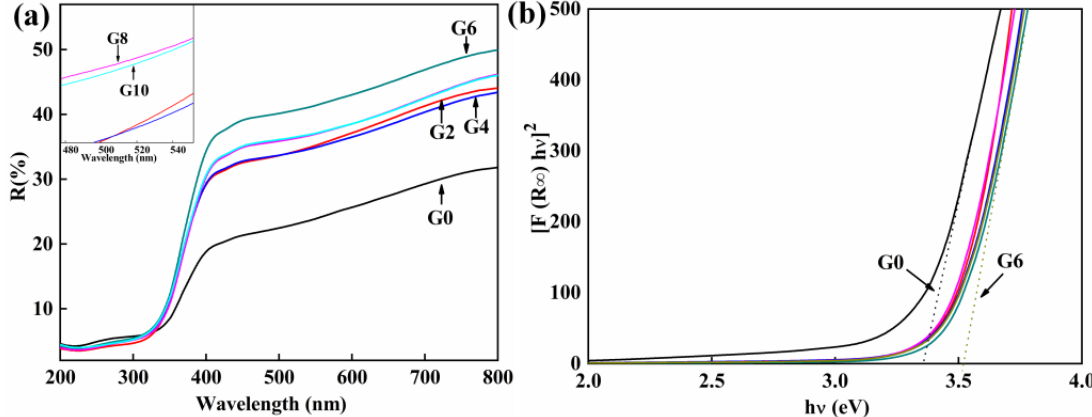
Figure 3. ( a ) The diffuse reflectance spectra of yttrium phosphate glasses. ( b ) The Kubelka–Munk transformed reflectance spectra of all glass samples.